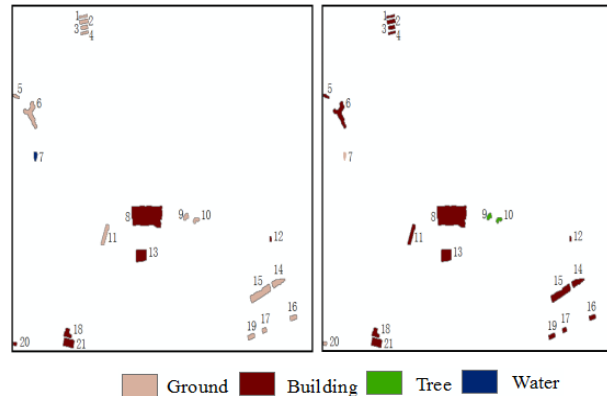
Figure 5. Decision tree classification result of two periods of datasets